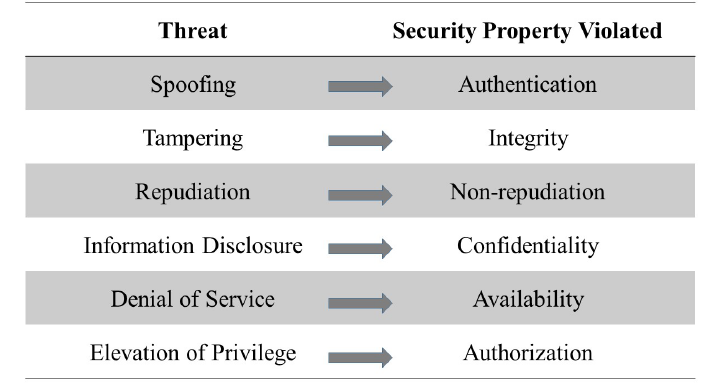
Figure 2. Representation of STRIDE Threat Model and Associated Security